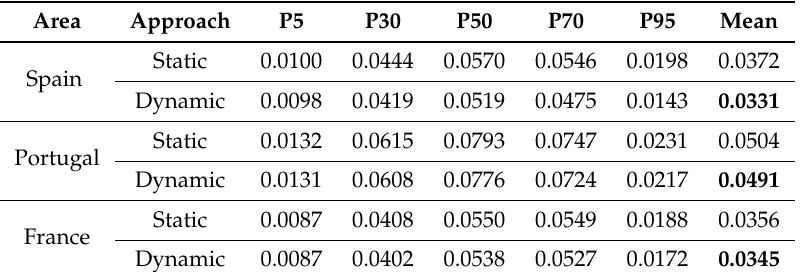
Table 3. Pinball loss function comparison on an hourly scale.